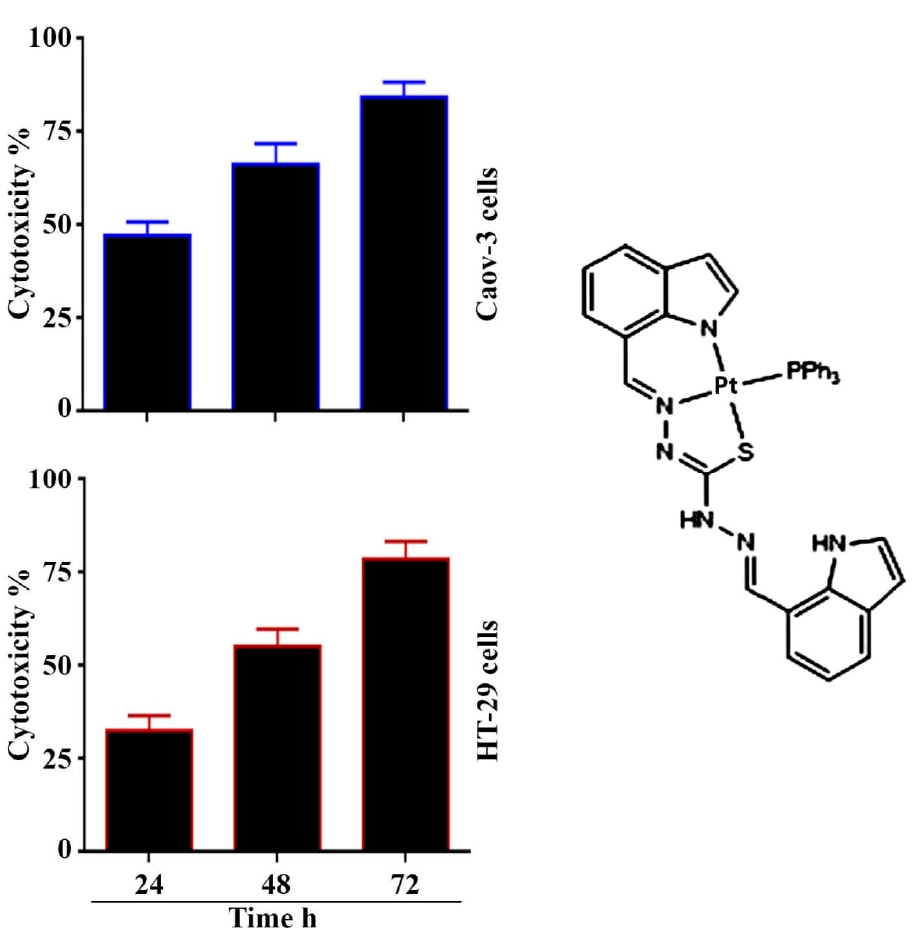
Figure 1. (left lane) Cytotoxicity of [Pt(H 2 L)(PPh 3 )] against Caov-3 and HT-29 cells at different time (24, 48 and 72 h). IC 50 for Caov-3 cells were 3.34, 2.41, 1.74 μ g mL − 1 , respectively. While, for HT-29 (24, 48 and 72 h). IC 50 for Caov-3 cells were 3.34, 2.41, 1.74 µ g mL − 1 , respectively. While, for HT-29 cells were 10.32, 4.25, 2.5 μ g mL − 1 , respectively. (right lane) Structure of Pt(II) complex. cells were 10.32, 4.25, 2.5 µ g mL − 1 , respectively. (right lane) Structure of Pt(II)